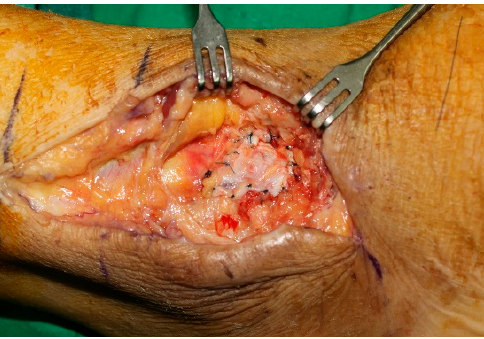
Figure 6. Joint capsule repaired and reinforced using a peroneal fascia flap.